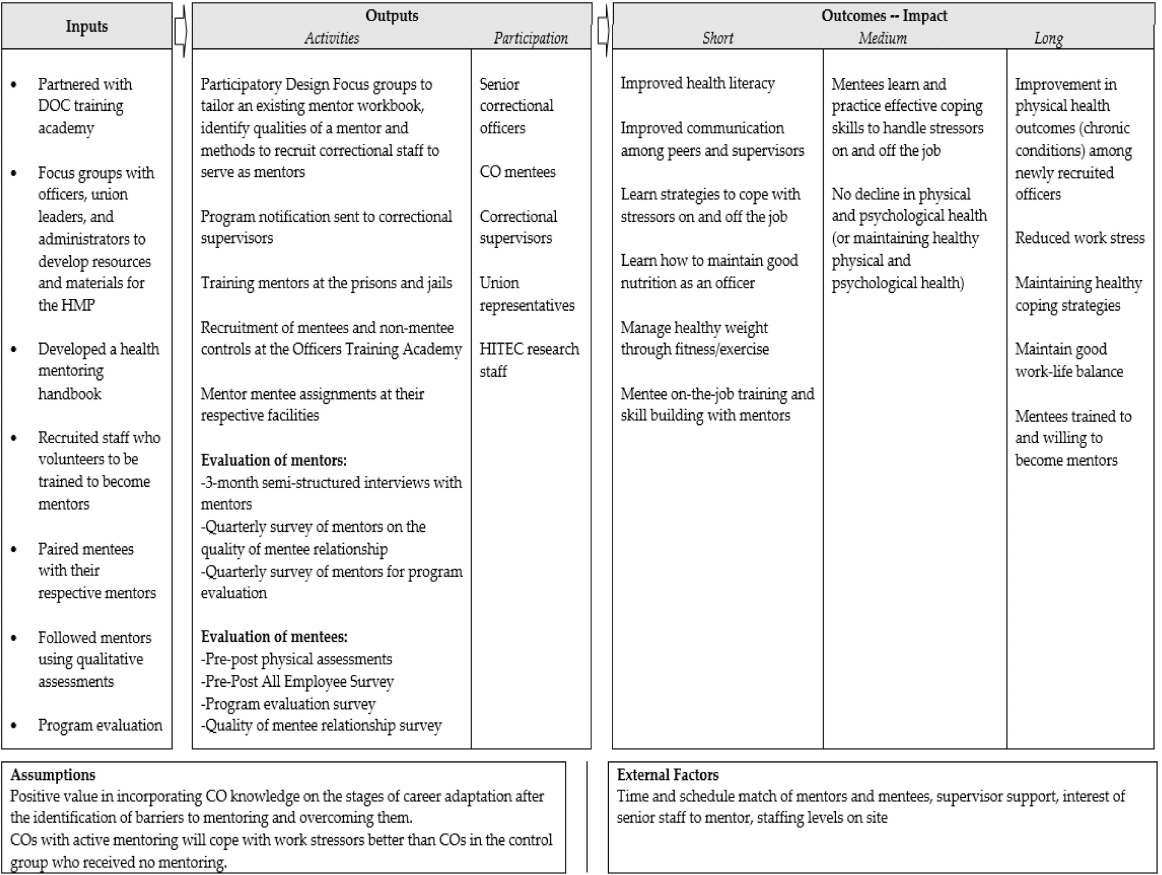
Figure 1. Logic model depicting the process of the Health Mentoring Program (HMP) for newly hired correctional officers